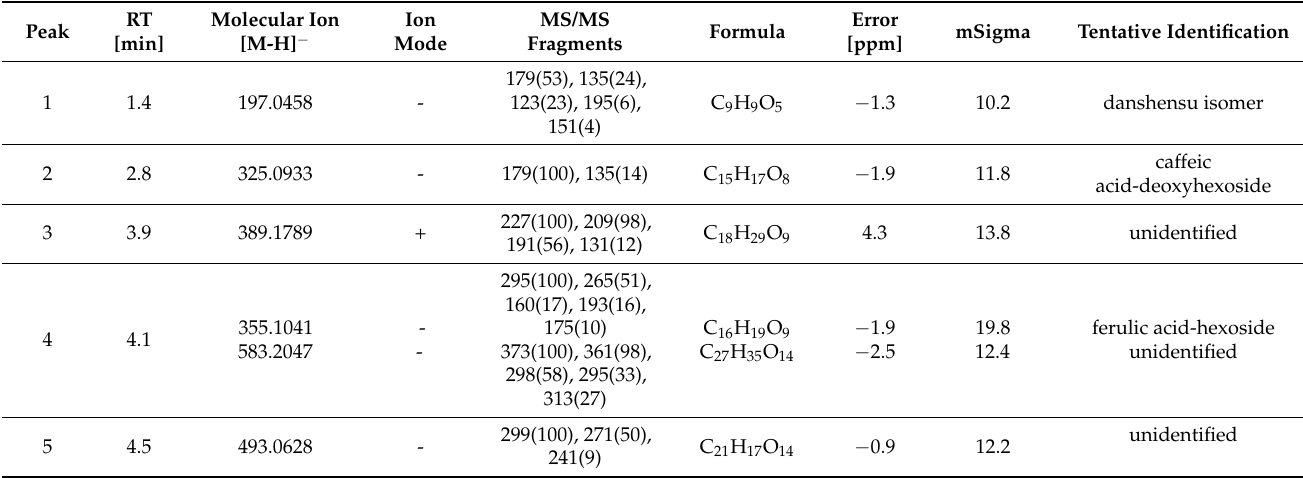
Table 4. Compounds identified in the sage ( Salvia officinalis L.) extract using UHPLC-QTOF-MS/MS. Compound numbers correspond to those indicated in Figure